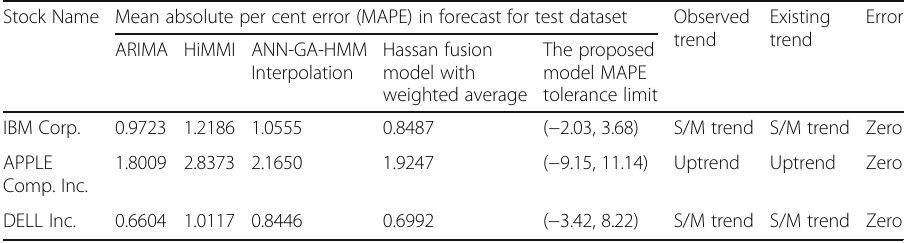
Table 7 Comparison of the outcome of the Markov chain and fuzzy interrelated method with other existing